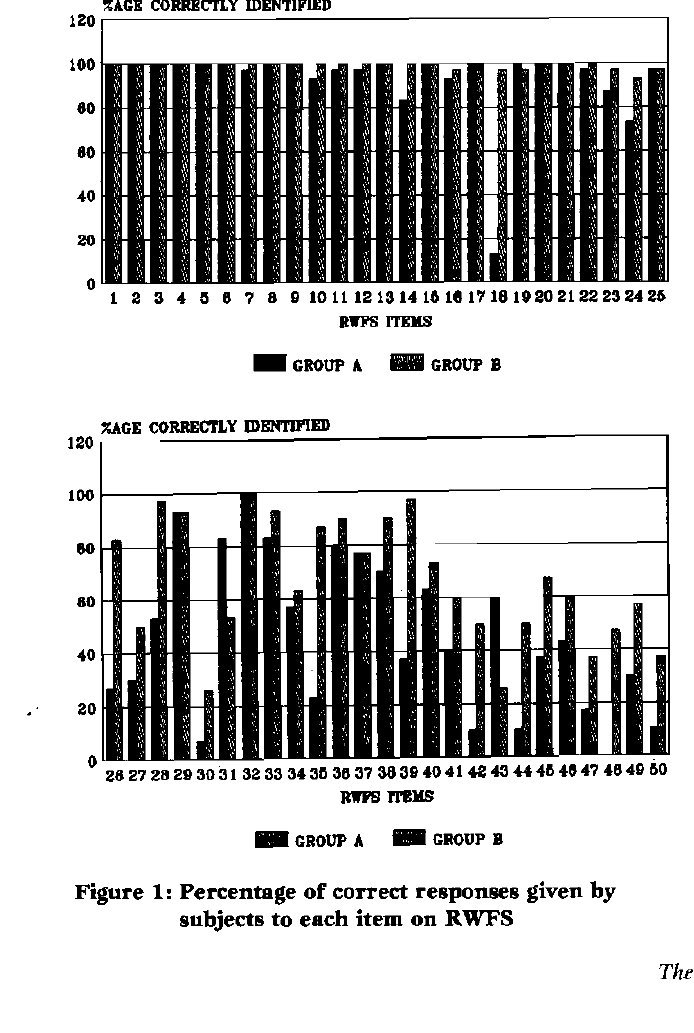
Figure 1: Percentage of correct responses given by subjects to each item on